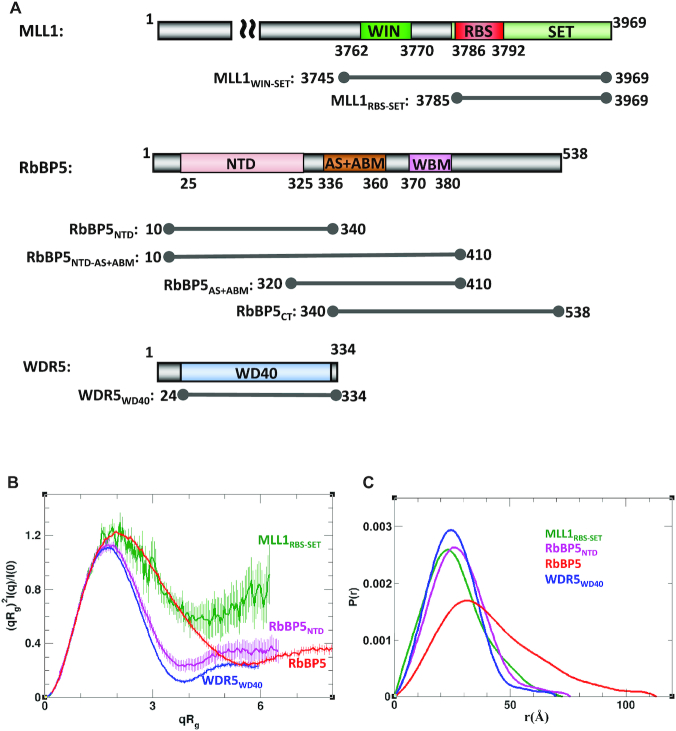
Individual components of the WDR5–RbBP5–MLL1 complex. (A) Schematic representation of MLL1, RbBP5 and WDR5 domain organization and constructs used in this study. For clarity, only the C-terminal region is displayed for MLL1. WIN: WDR5 interacting motif as previously defined (41); RBS: RbBP5 binding site as defined in this study; SET: catalytic methyltransferase domain; NTD: N-terminal domain; CT: C-terminus; AS+ABM: activation segment and ASH2L binding motif as defined in (35); WBM: WDR5 binding motif (43). (B) SAXS-derived Rg-based Kratky plots indicate that WDR5WD40 (blue) and RbBP5NTD (magenta) are globular, while RbBP5 (red) and MLL1RBS-SET (green) exhibit some degree of flexibility. The error bars show propagated experimental errors. (C) Normalized pair distance distribution functions P(r) calculated from experimental SAXS data with GNOM.